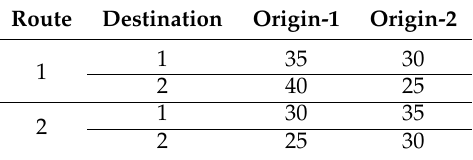
Table 5 represent the distances from different origins to destinations by route-1 and route-2. Table 5. Distances ( ds ijp ) of the routes for the